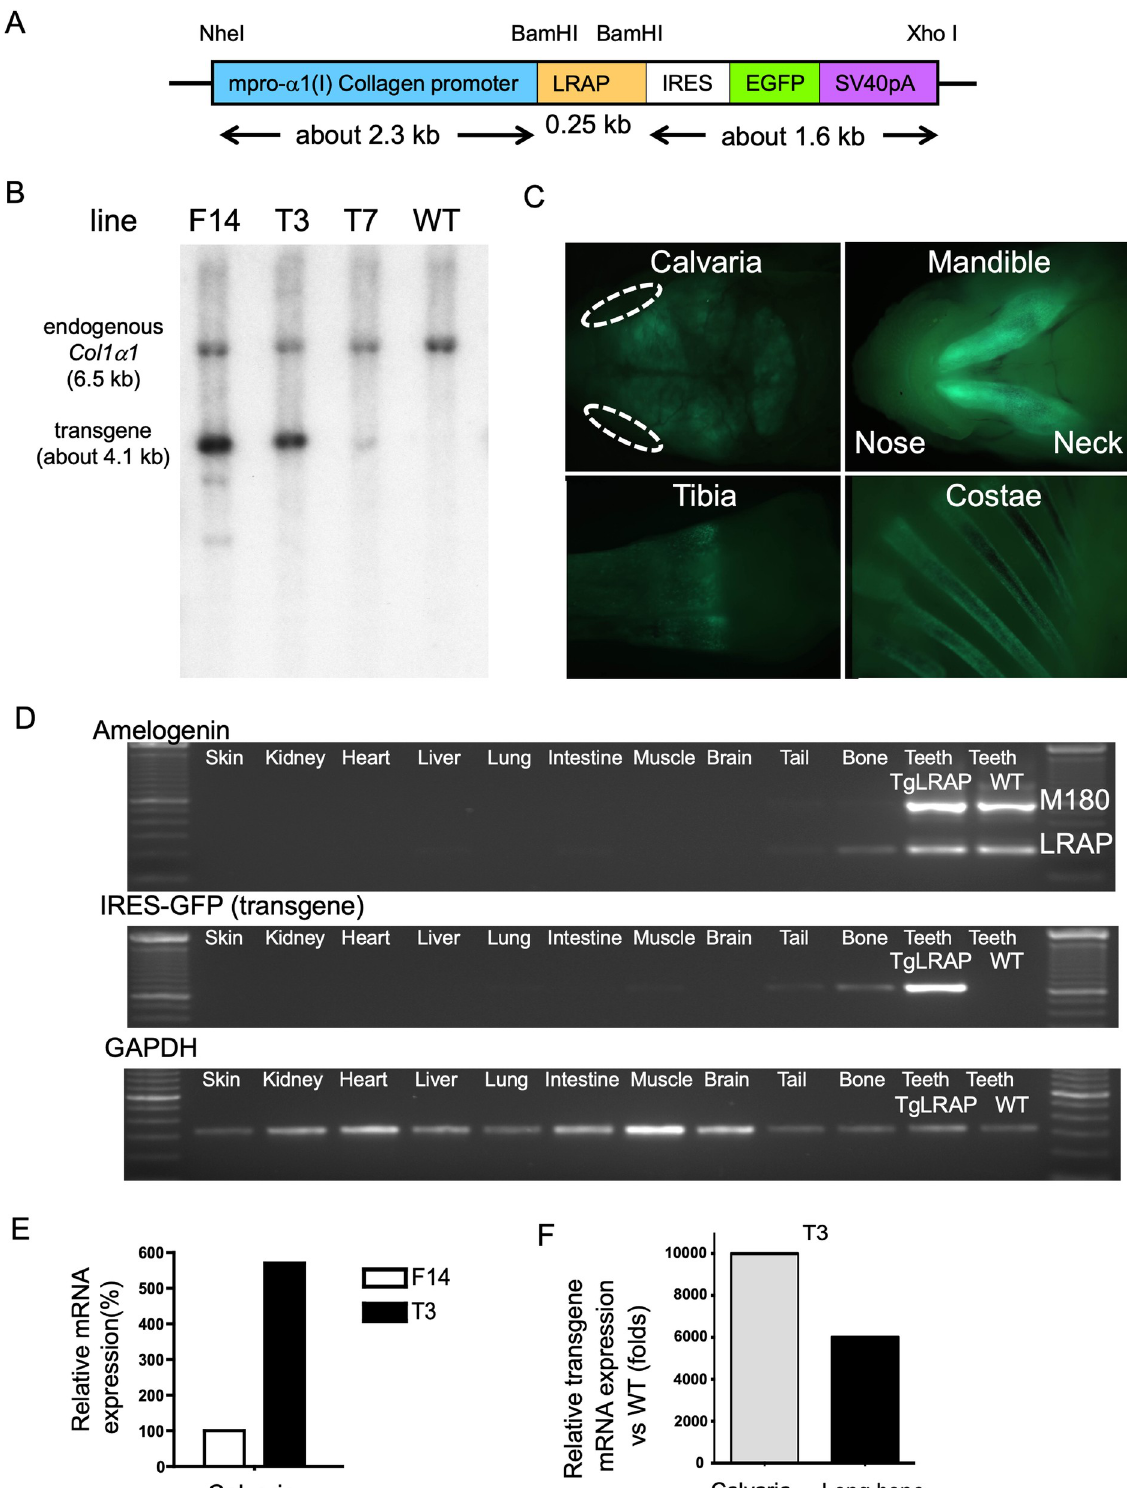
Fig 1. Generation of LRAP transgenic (TgLRAP) mice and transgene expression profiling. A , Construct for LRAP transgenic mouse. Mouse LRAP cDNA and an enhanced green fluorescence protein (EGFP) coding sequence with IRES sequence were tandemly ligated under the control of murine 2.3kb type I collagen promoter. The DNA fragment from NheI to XhoI was microinjected to pronuclei of mouse eggs.